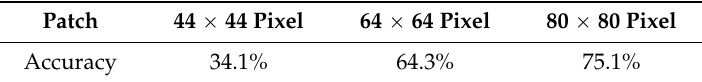
Table 2. The recognition rates of the cropped images using SRC.